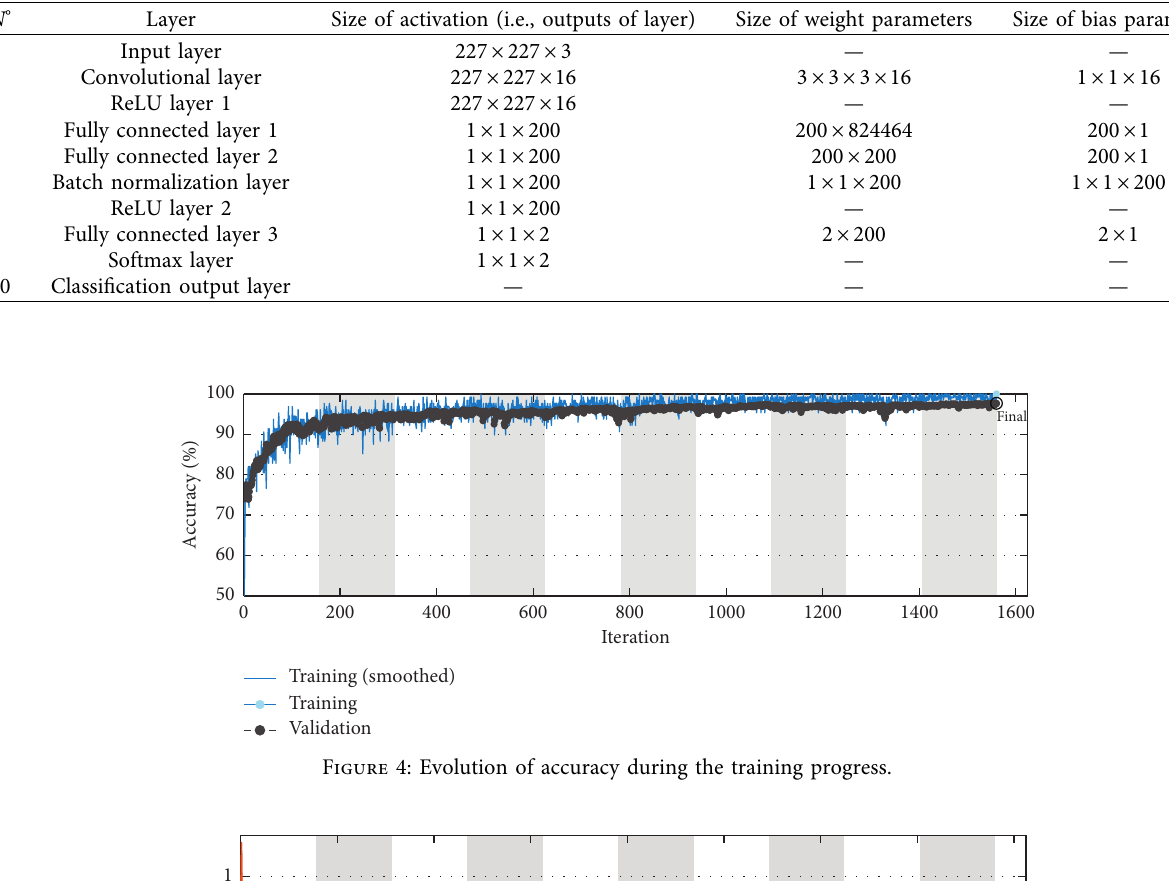
Table 3: Details of CNN’s architecture.